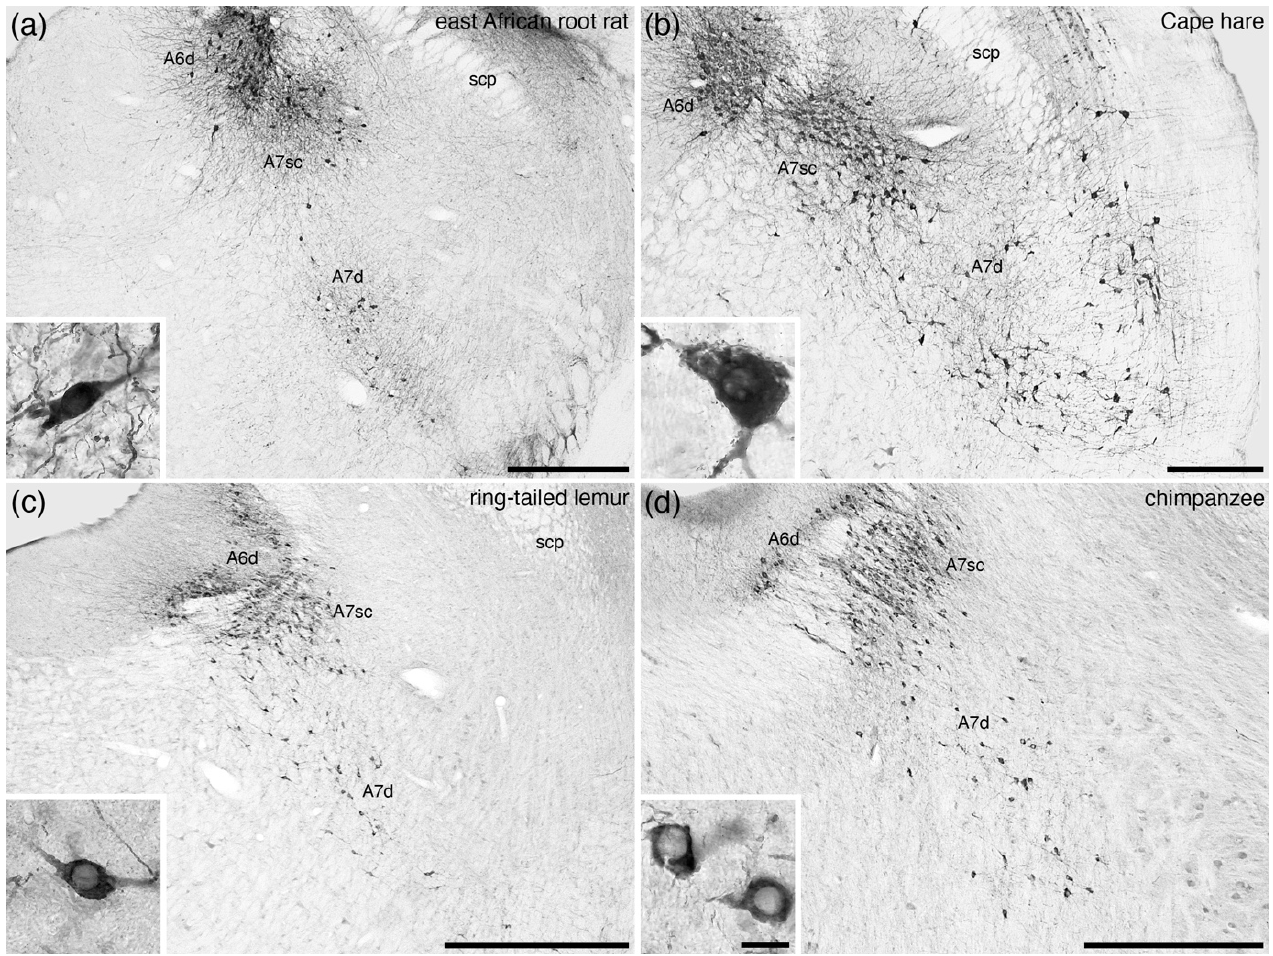
Figure 11. Low-magnification photomicrographs of the subcoeruleus, or A7, region revealed with immunostaining for tyrosine hydroxylase in four mammalian species belonging to the Euarchontoglires superorder of Eutherian mammals, including ( a ) the east African root-rat ( Tachyoryctes splendens ) [pers. obs.], ( b ) Cape hare ( Lepus capensis ) [50], ( c ) the ring- tailed lemur ( Lemur catta ) [52], and ( d ) the chimpanzee ( Pan troglodytes ) [58]. Note the presence of the compact portion of the subcoeruleus ( A7sc ) in the dorsal aspect of the parvicellular reticular nucleus, with scattered more widely distributed neurons throughout the parvicellular reticular nucleus forming the diffuse portion of the subcoeruleus ( A7d ). Insets in each image show a high-magnification image of the neurons that form the A7d in each species. In all images, dorsal is to the top and medial to the left. Scale bars in ( a , b ) = 500 µm and apply to the respective images. Scale bars in ( c , d ) = 1 mm and apply to the respective images. Scale bar in inset d = 25 µm and applies to all insets. scp —superior cerebellar peduncle.